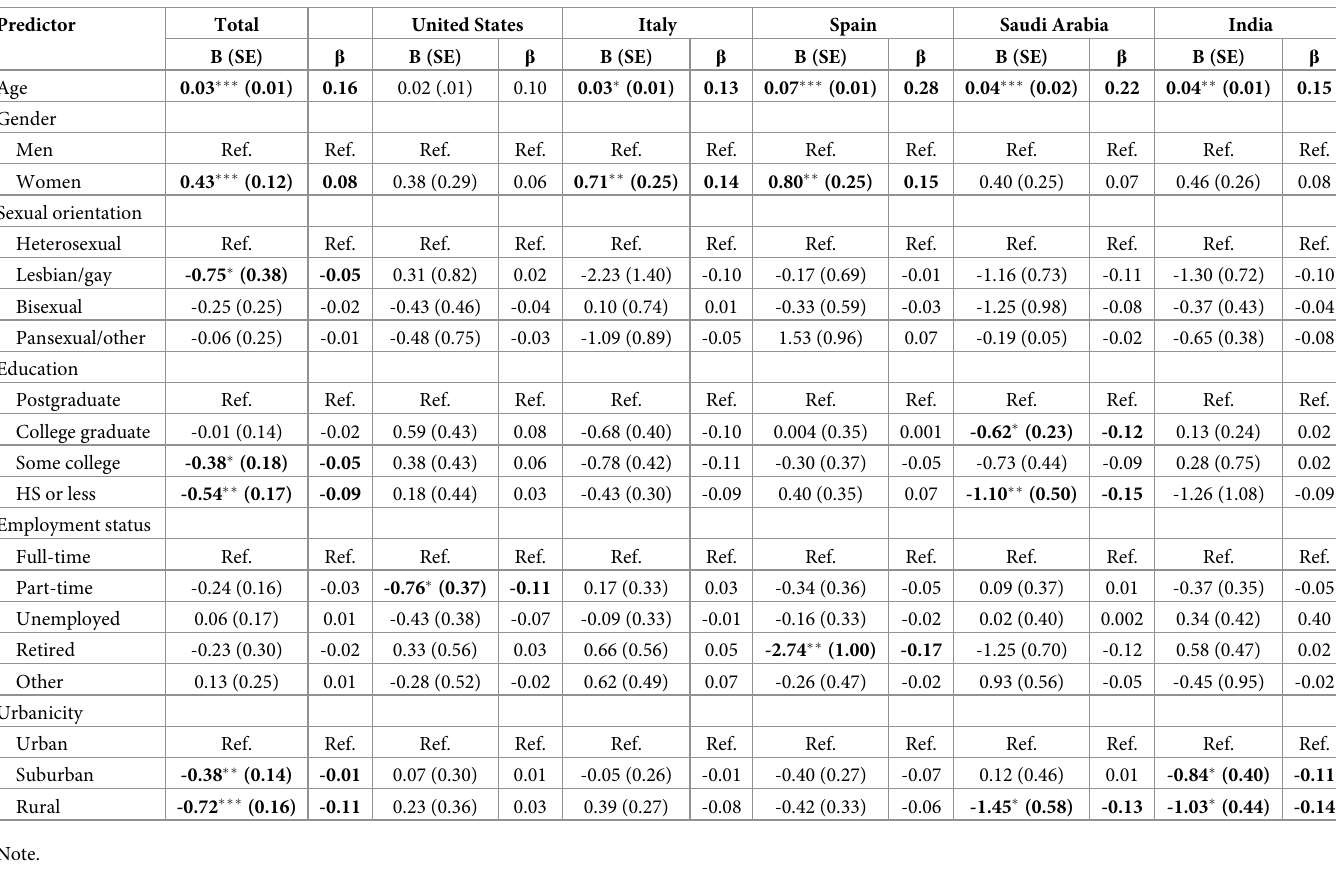
Table 2. Unstandardized and standardized multivariable linear regression weights for social distancing, stratified by country. Predictor United